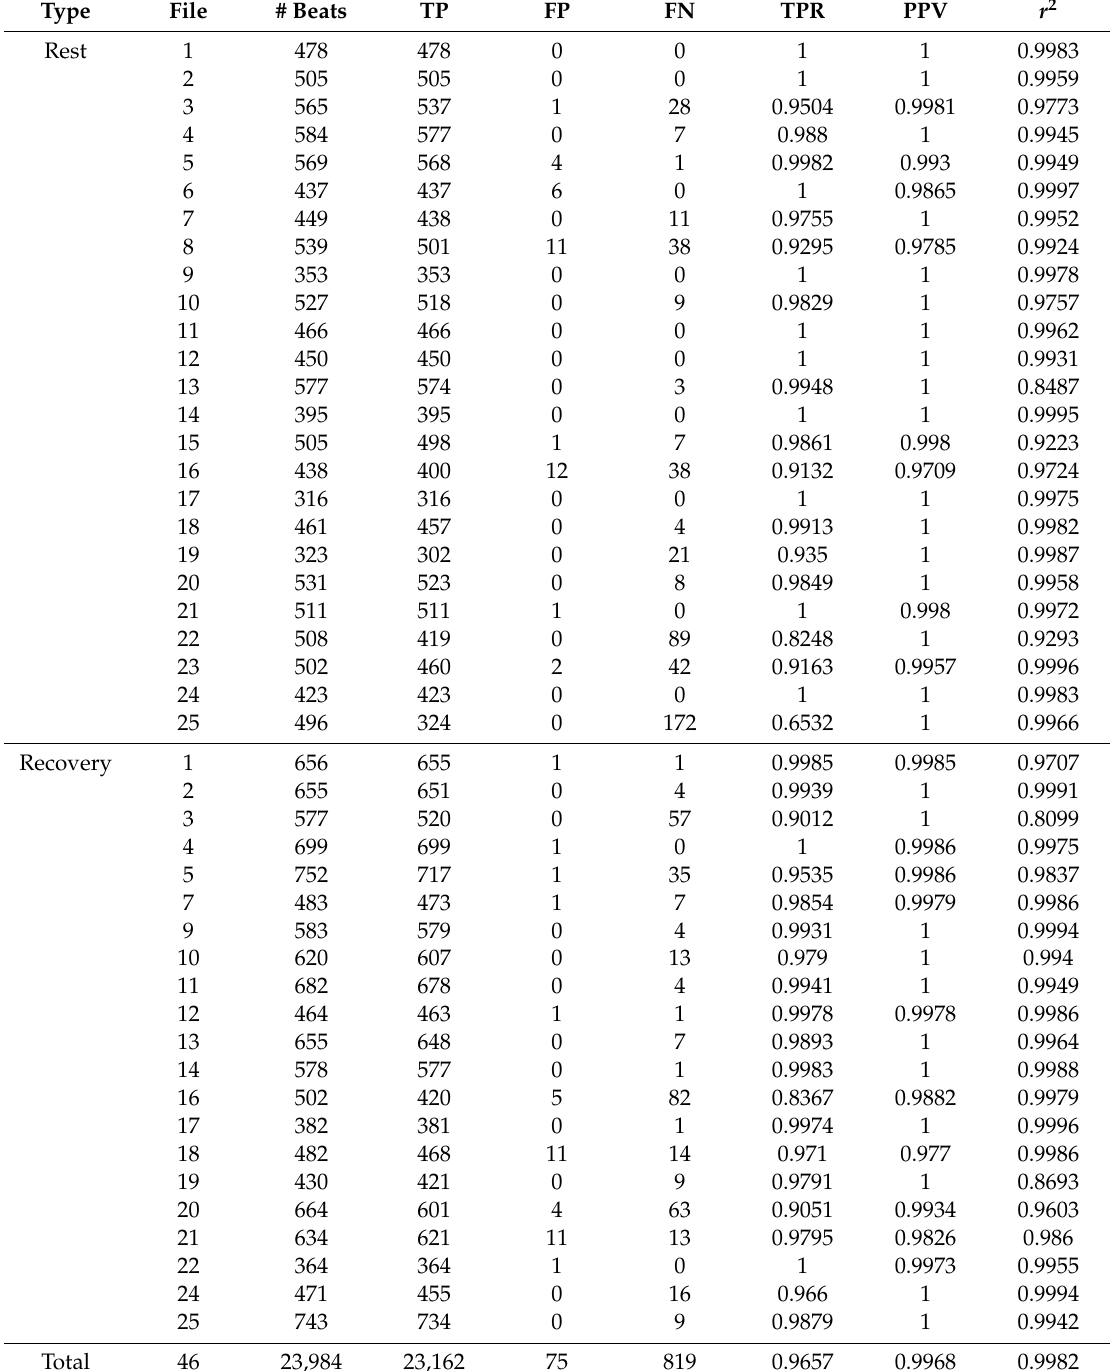
Table 1. AO detection results for number of beats, true positive beats, false positive beats, false negative beats, true positive rate, positive prediction rate, and heart rate r 2 coe ffi